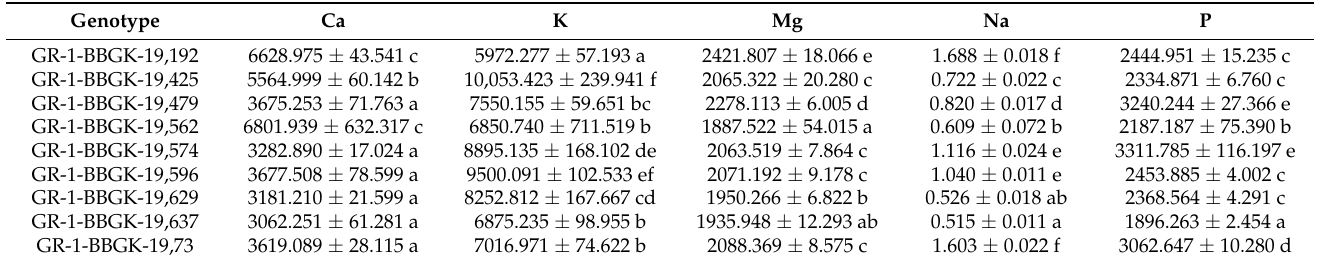
Table 2. Concentrations of macro-elements measured in leaves of cultivated germplasm of nine